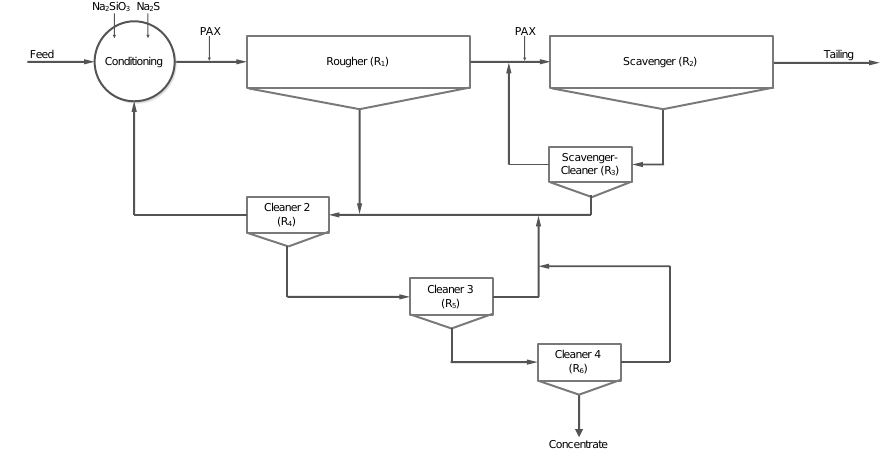
Figure 6. Lead flotation circuit.